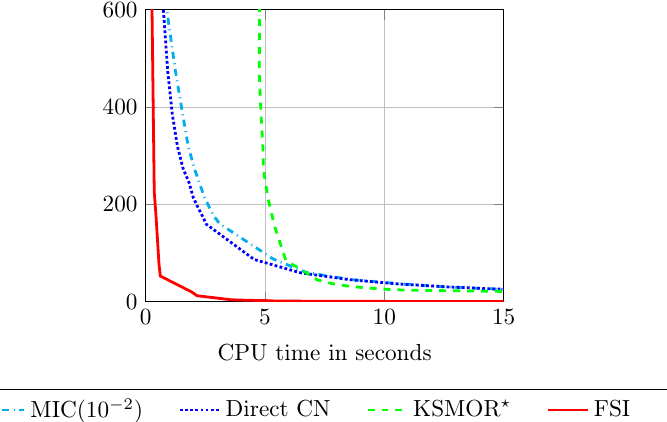
Figure 8. Results of the two-dimensional GES experiment without source: comparison of the L 2 -error and the corresponding CPU time between MIC(10 − 2 ), direct CN, KSMOR (cid:63) and FSI at t F = 2.609 for h = 0.04. KSMOR (cid:63) is performed with q = 3 and s = 20. The reference solution is computed with the EE method. The FSI method clearly outperforms all other